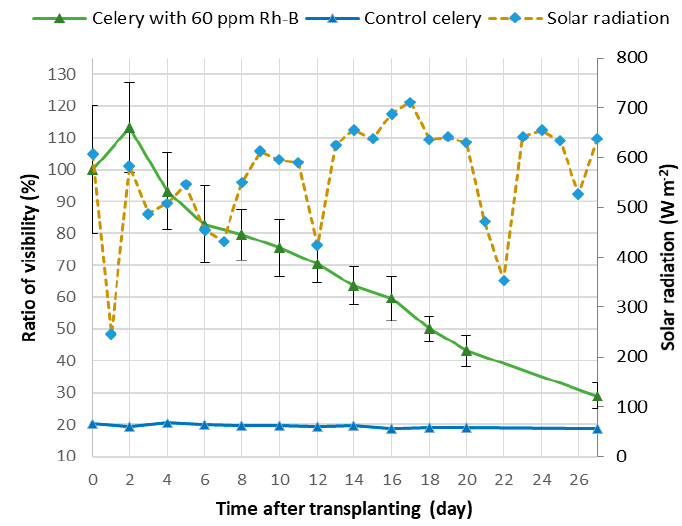
Figure 1. Rh–B (Rhodamine B) visibility in celery plants for 27 days under sunlight [46].